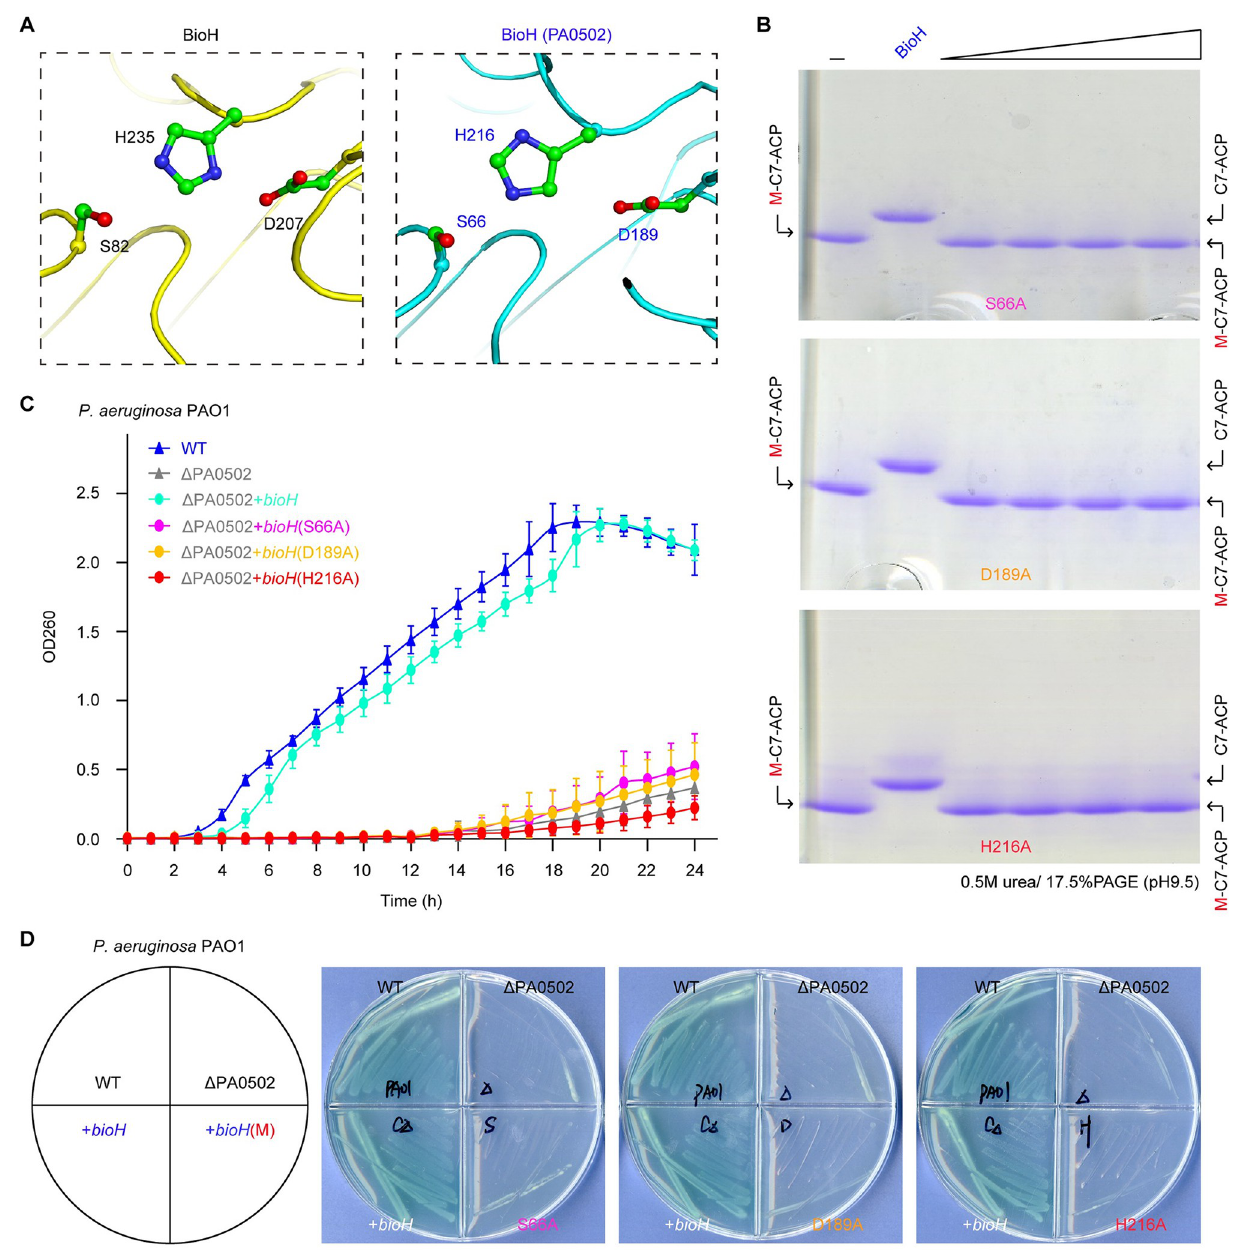
Fig 3. Functional characterization of BioH (PA0502) catalytic triad (S66, D189, and H216). A. Structural snapshot of BioH catalytic triad. The structure of E . coli BioH (PDB: 1M33) is generated with PyMol, and the structural model of PA0502 was predicted with Alpha-fold [79]. The catalytic triad of E . coli BioH consists of S82, D207, and H235. Equivalently, they denote S66, D189, and H216 in PA0502. B. The in vitro enzymatic assays reveal that none of three single mutants defective in catalytic triad is active. Namely, the three single mutants of PA0502 include S66A, D189A, H216A. The conformationally-sensitive gel of 0.5 M urea/17.5% PAGE (pH9.5) was applied to distinguish the product C7-ACP from its reactant M-C7-ACP. The minus symbol denotes no addition of PA0502. The positive control refers to the addition of wild-type PA0502 (50 nM). The triangle on right hand denotes varied level of PA0502 mutant (ranging from 0.5, 5, 50, to 500 nM). C. Growth curve analysis of P . aeruginosa PAO1 suggested that catalytic triad is essential for PA0502 activity. The graph was plotted with data collected from three independent measurements, and presented in an average ± standard deviations (SD). D. The alanine substitution of catalytic triad inactivates the ability of PA0502 to restore bacterial growth of the biotin auxotrophic strain Δ PA0502 on the non-permissive, biotin-deficient condition of M9 minimal medium.